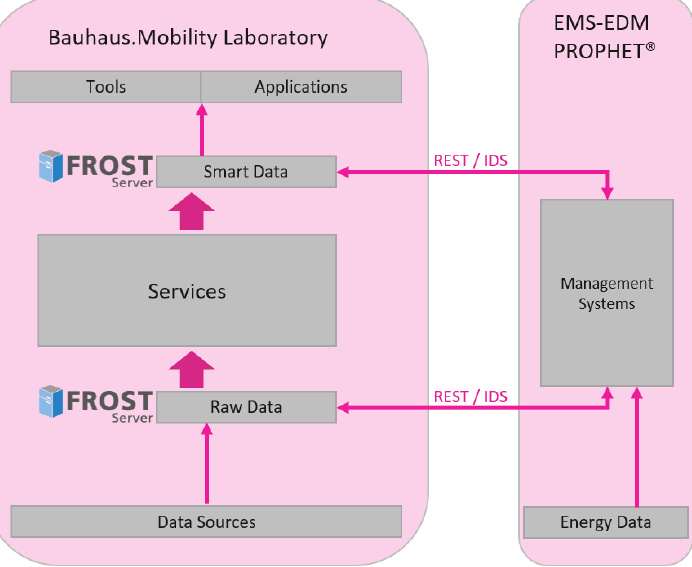
Figure 2. Integration of the Fraunhofer Energy Management System in the